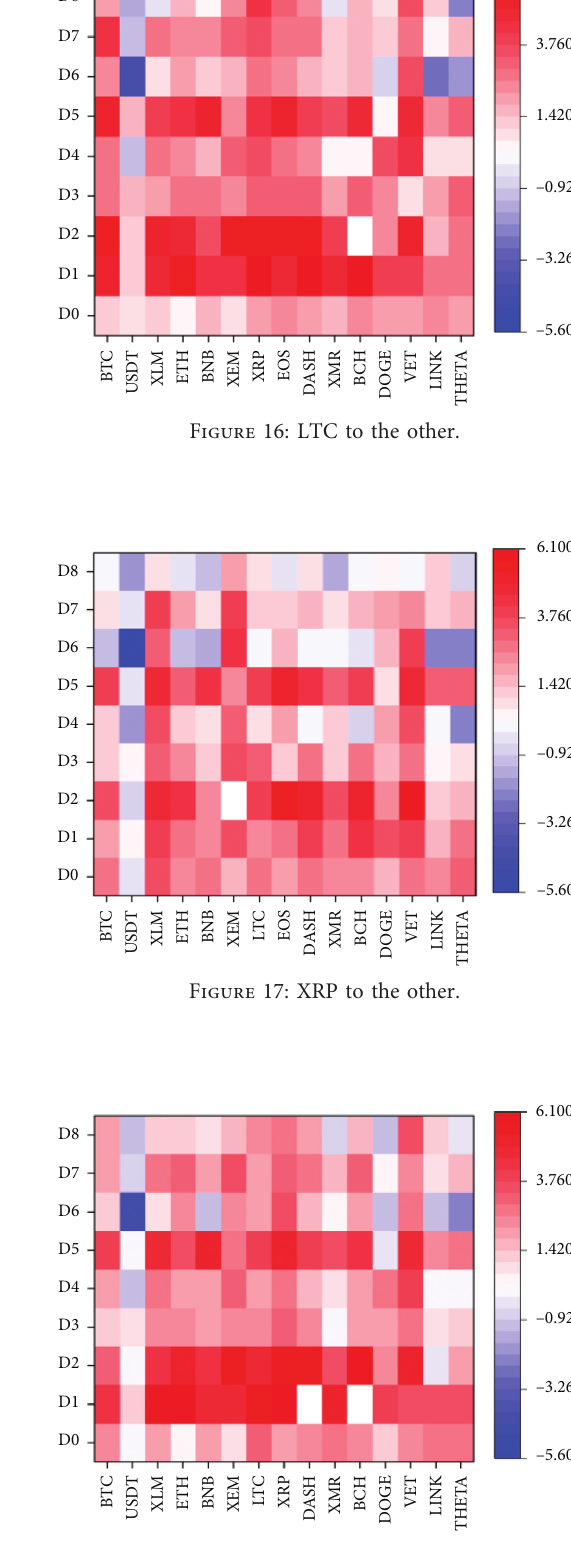
Figure 18: EOS to the other.